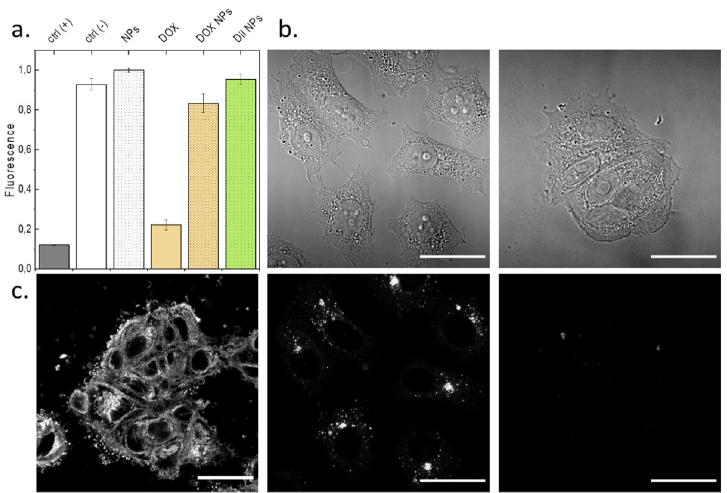
Fig 4. Bioevaluation of formulated NPs. a. Presto Blue Cell viability assay graph demonstrating viability of MCF-7 cells exposed to different NPs for 72h b. Confocal microscopy transmission images of MCF-7 cells incubated with DiI loaded NPs (left), and MCF-7 cells exposed to NPs without loading (right). c. Fluorescent confocal microscope images of the MCF-7 cells exposed to (left to right): DiI, DiI loaded NPs (corresponding the transmission image above), NPs without cargo (corresponding to the transmission image above). All scale bars 30 μ